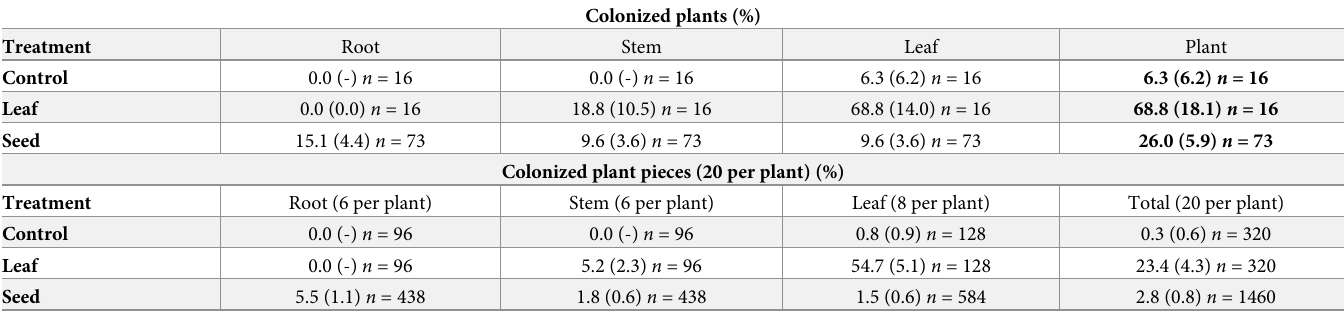
Table 1. Colonization of V . faba plants by endophytic B . bassiana in fecundity tests with A . fabae .